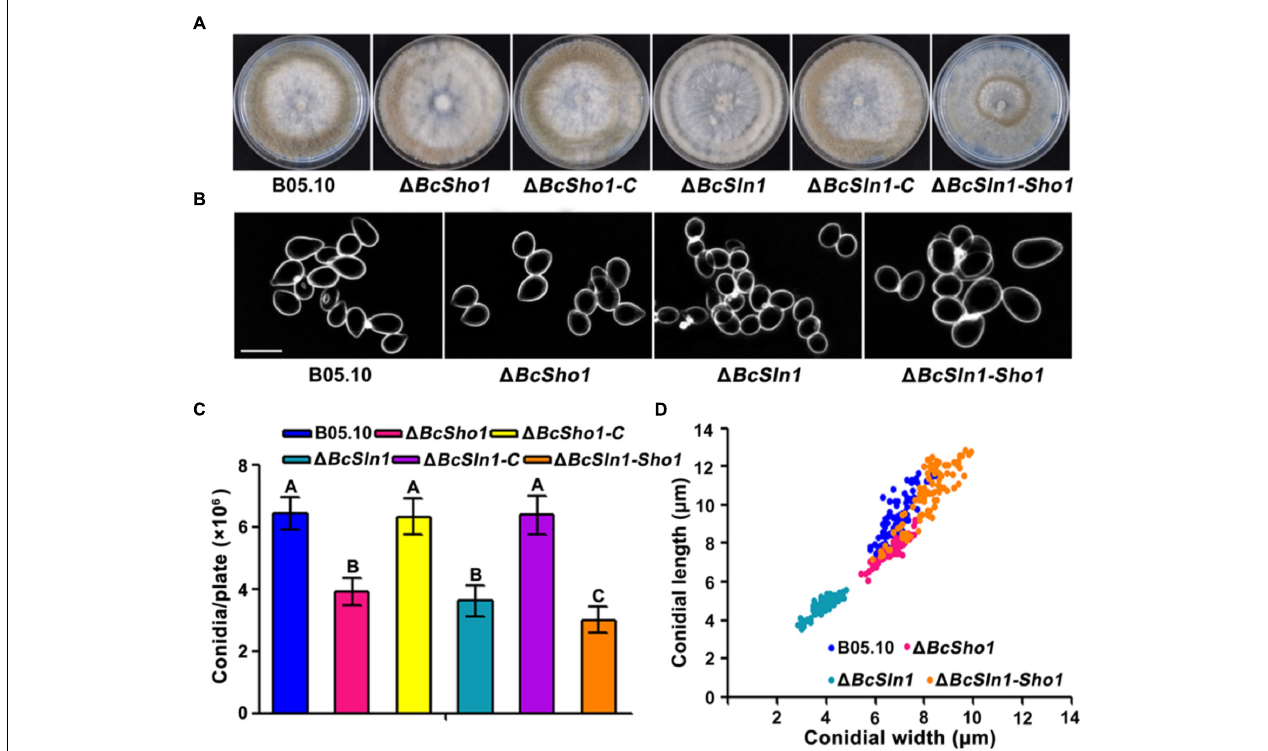
FIGURE 3 | Roles of BcSHO1 and BcSLN1 in conidiation. (A) Comparison of conidiation among B05.10, (cid:49) BcSho1 , (cid:49) BcSln1 , and (cid:49) BcSln1-Sho1 after 10 days incubation on PDA plates at 20 ◦ C under white light. (B) Conidial morphology of the each strain. Scale bar 10 µ m. (C) The number of conidia produced by each strain. Bars represent standard errors from three replications. Values on the bars followed by the same letter are not significantly different at P = 0.05. (D) Conidial size of the each strain. More than 100 conidia were measured under a microscope in each experiment.